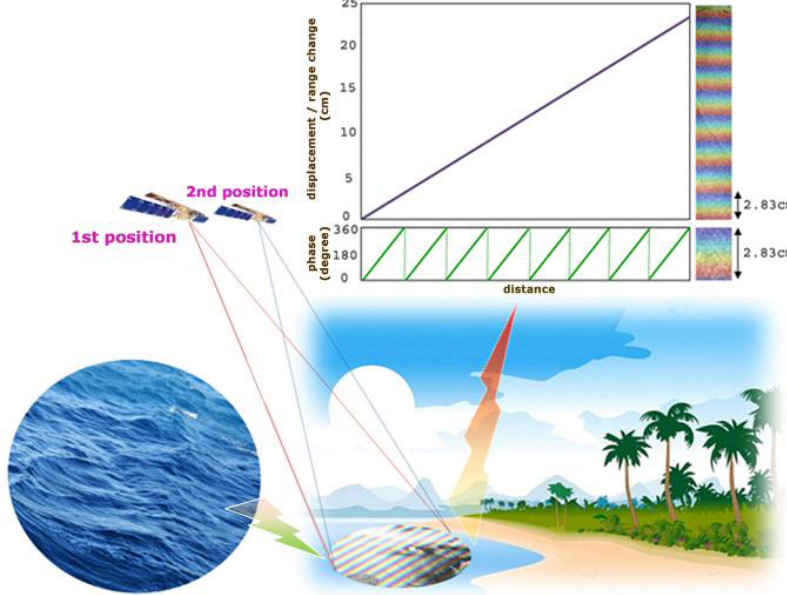
Figure 6: Diagram clarifying Liqui-InSAR